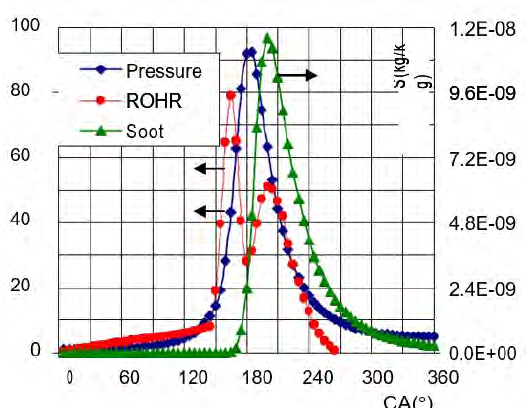
Figure 3. Rate of heat release, pressure and soot concentration vscrank angle of biogas diesel dual fuel engine combustion (D15, ϕ =1.2,